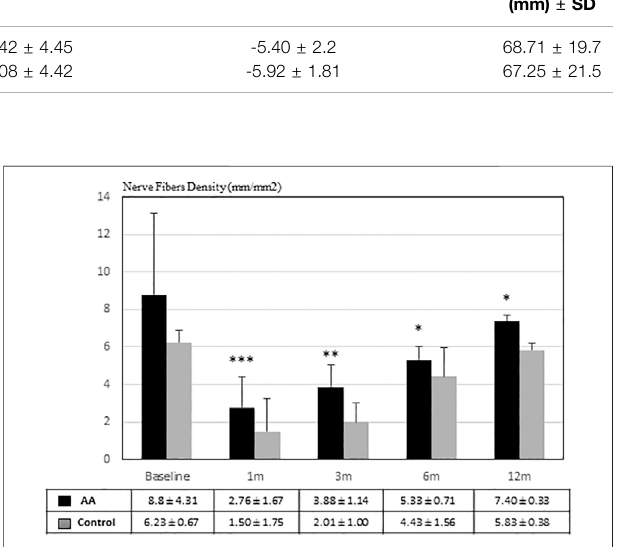
FIGURE 1 | Presence of nerve fi bers during follow-up. Evaluation of the number of fi elds (3 fi elds/patient) presenting nerve fi bers at the indicated time points. At 1 and 3 months corneal nerve regeneration resulted to be signi fi cantly faster in patients treated with AA than in the control group (*** p < 0.001 by Fisher ’ s exact test).